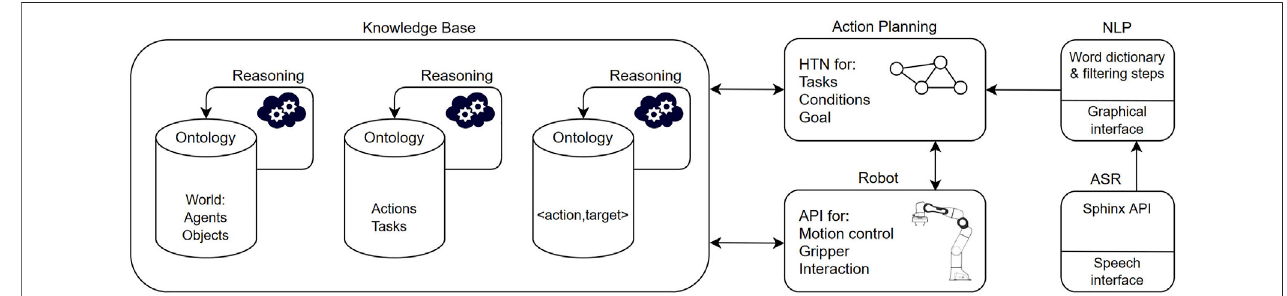
FIGURE 1 | The system architecture is divided in several blocks as follows. The knowledgebase (KB) holds all knowledge of the world in form of ontologies, which are updated by reasoning and human input. Action planning generates shared plans in form of hierarchical task networks (HTN), which take input from the KB. Robot capabilities are integrated via a separate robot application programming interface (API) where skills and motion primitives are de fi ned. Automated speech recognition (ASR) and natural language processing (NLP) are separate modules that provide the human input for coordinating the collaborative tasks.